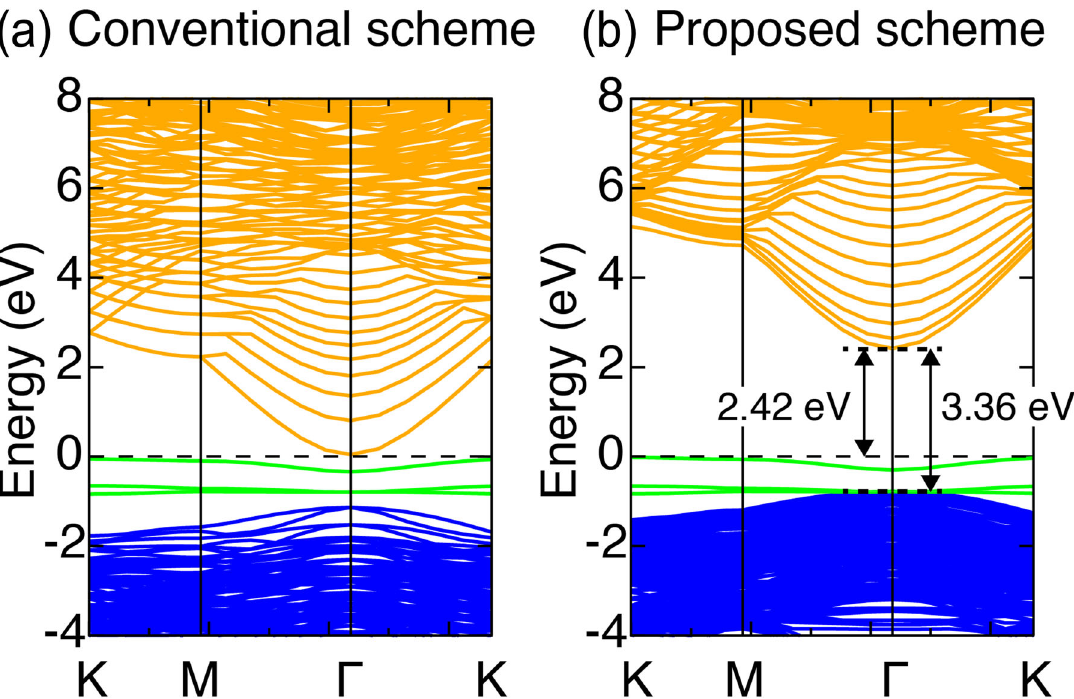
Fig. 6 Band structure calculated for the WZ ZnO(0001) (2 × 2)-O ad structure. Band structures are obtained using a the conventional and b the proposed passivation schemes for the O — side of the slab. The energy of the highest occupied state is set to 0 eV, and the CB, VB, and surface states are shown as orange, blue and green solid lines, respectively. The energy differences between the highest occupied state (a surface state) and the CBM, and between the VBM and the CBM are